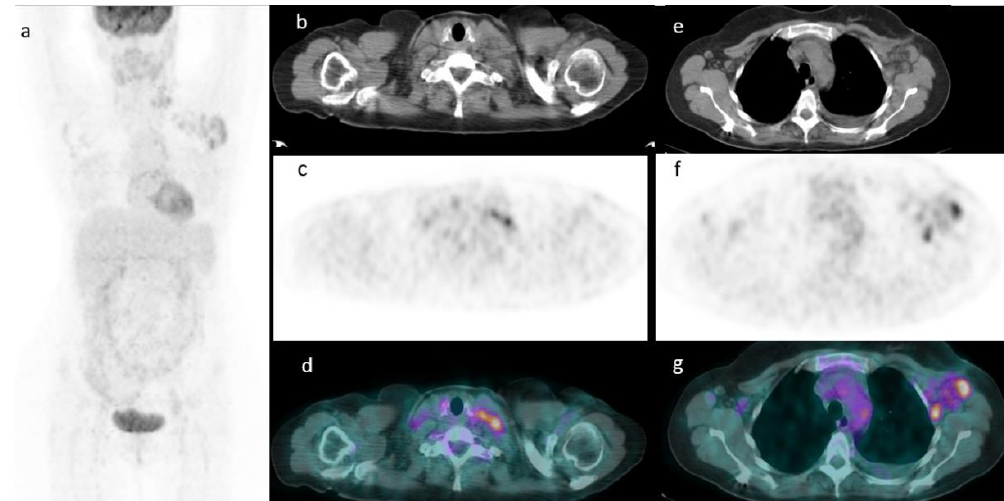
Figure 1. An example of a patients with FDG-avid laterocervical and axillary nodes at maximum intensity projection (MIP) ( a ). Axial CT ( b ), PET ( c ), and PET/CT fused images ( d ) confirming the presence of lymph nodes in left-side neck and in the left axilla ( e – g ). Table 2. Comparison between SUVmax, lesion-to-liver SUVmax ratio, lesion-to-blood pool SU- Vmax ratio, and the main clinical-pathological features.